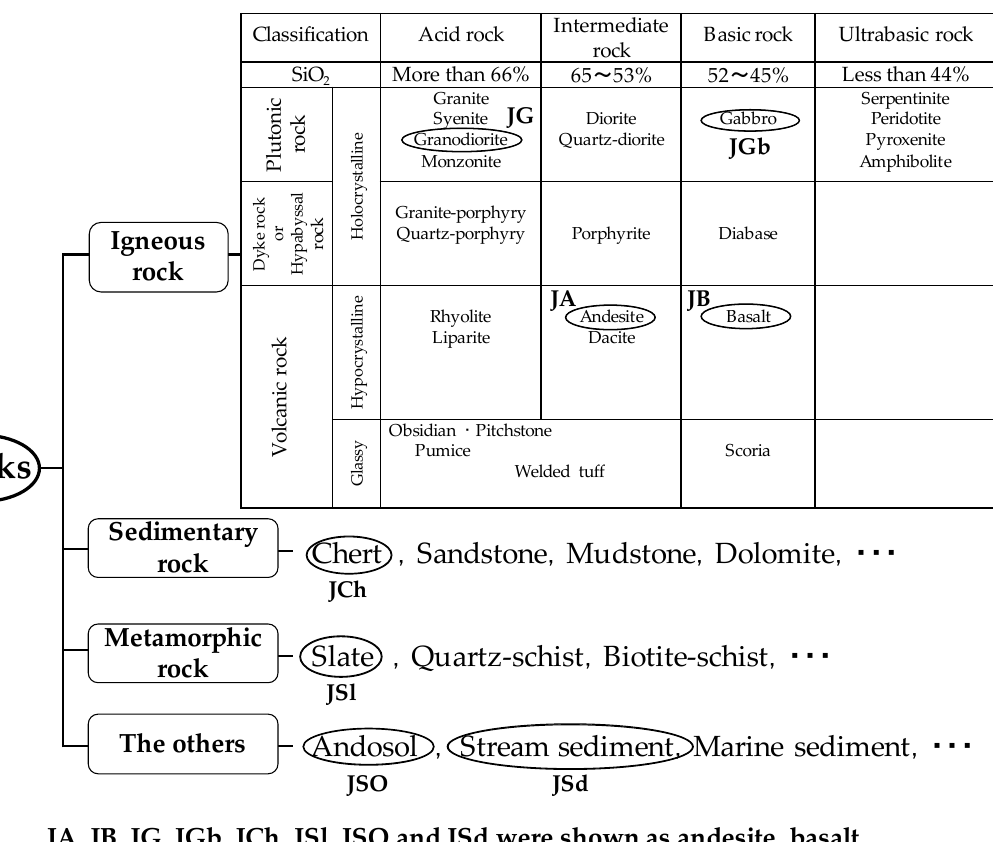
Figure 1. Classification of rocks used in this study: igneous rock (JA, JB, JG, and JGb), sedimentary rock (JCh), metamorphic rock (JSl), and other rocks (JSO and JSd).